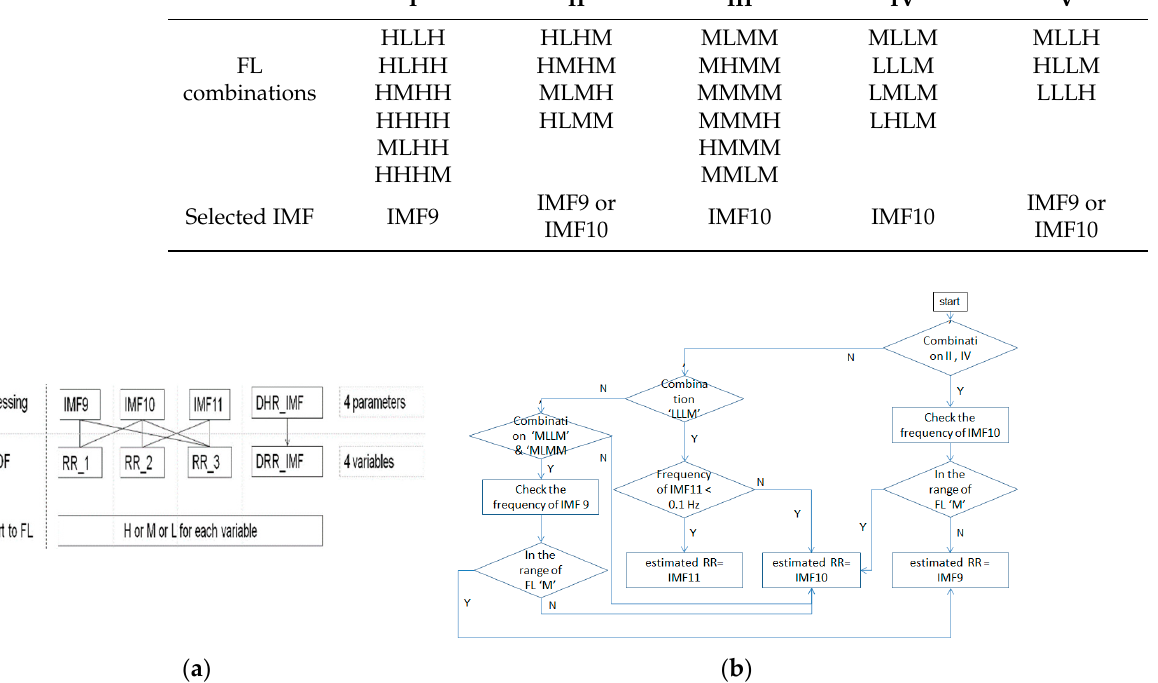
Figure 4. ( a ) The processing of SDF; ( b ) the flow of checking IMF10. Table 3. The selection rule using combinations of frequency